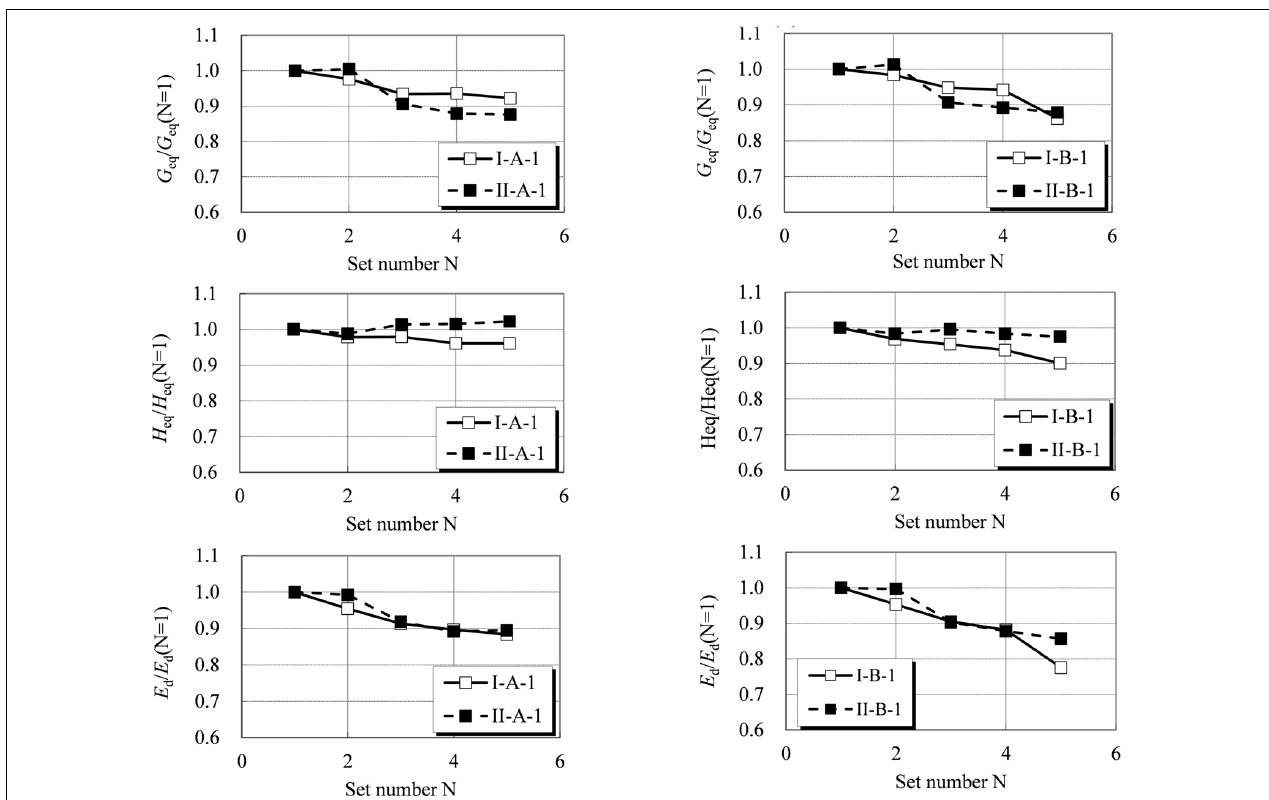
FIGURE 6 | Change of characteristics in benchmark test [BT(1) to BT(5)] of scale-I and -II at 3rd cvcle.